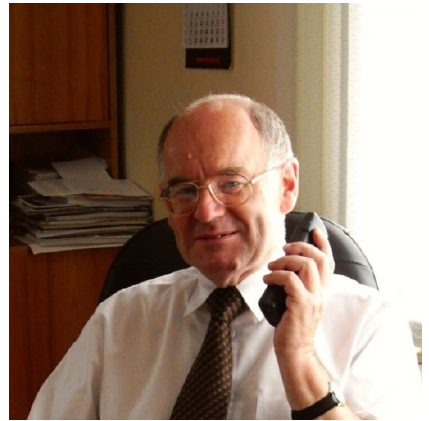
Figure 5. Andrzej Pilarczyk at his office in 2009. He obtained his PhD degree